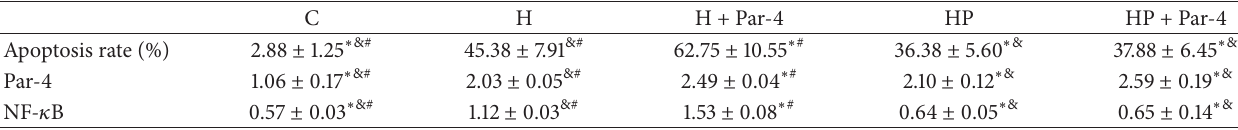
Table 6: The apoptosis rate and nuclear protein expression of Par-4 and NF- 𝜅 B of each group. C H H + Par-4 HP HP +